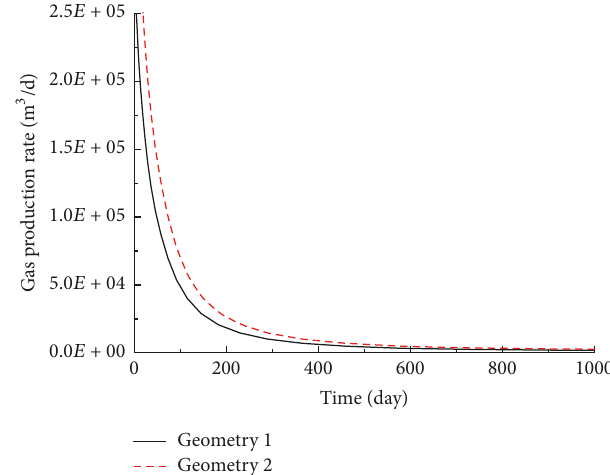
Figure 11: Effect of fracture geometry on gas production